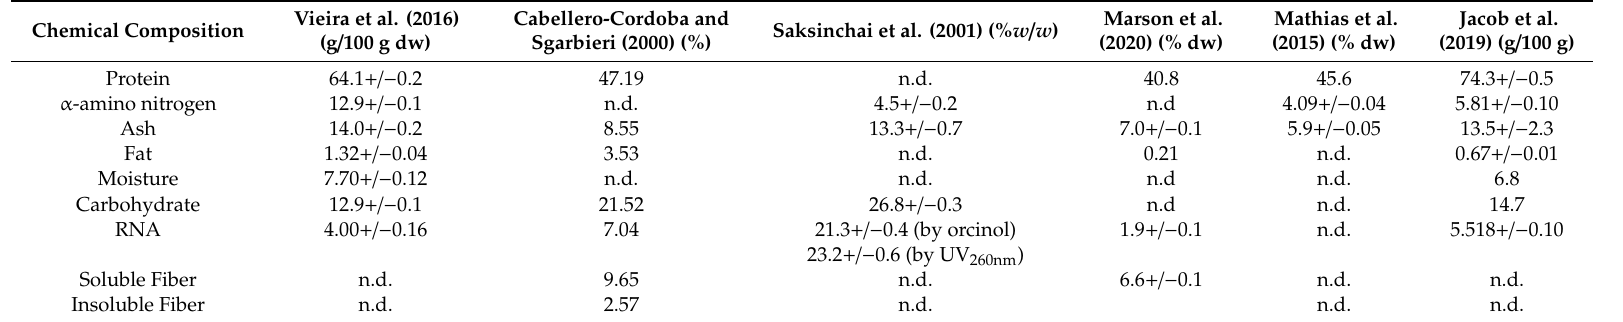
Table 1. Chemical Composition of Brewer’s Spent Yeast.